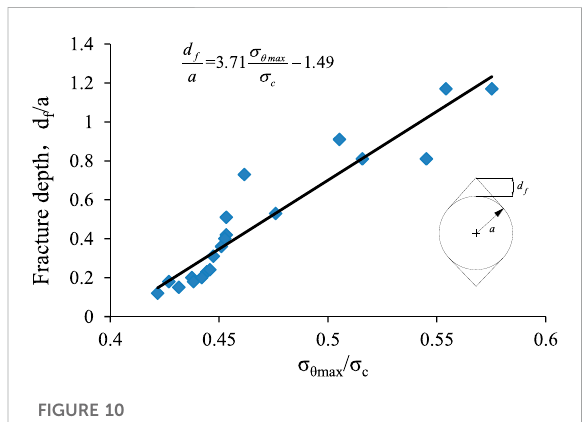
FIGURE 10 Theproposedequation offracturedepthofsurroundingrock in mining roadway.